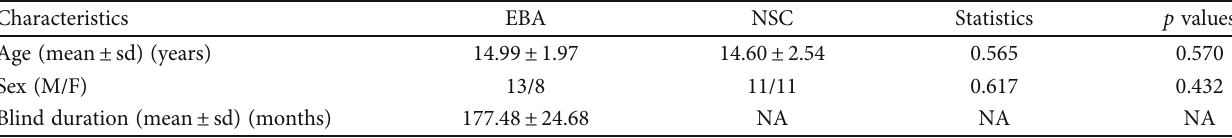
Table 3: Demographics and clinical characteristics of all